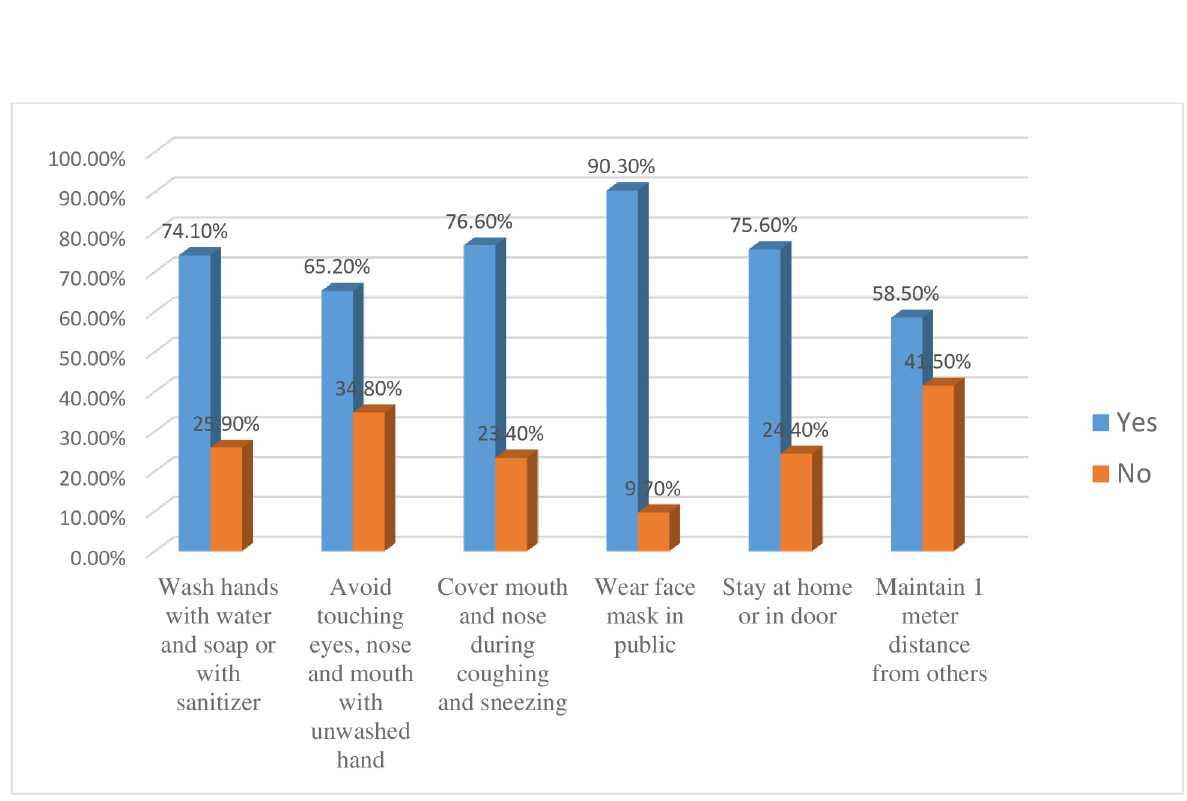
Fig 2. Adherence to specific COVID-19 preventive practice among pregnant women in Gondar city, northwest Ethiopia, 2021.